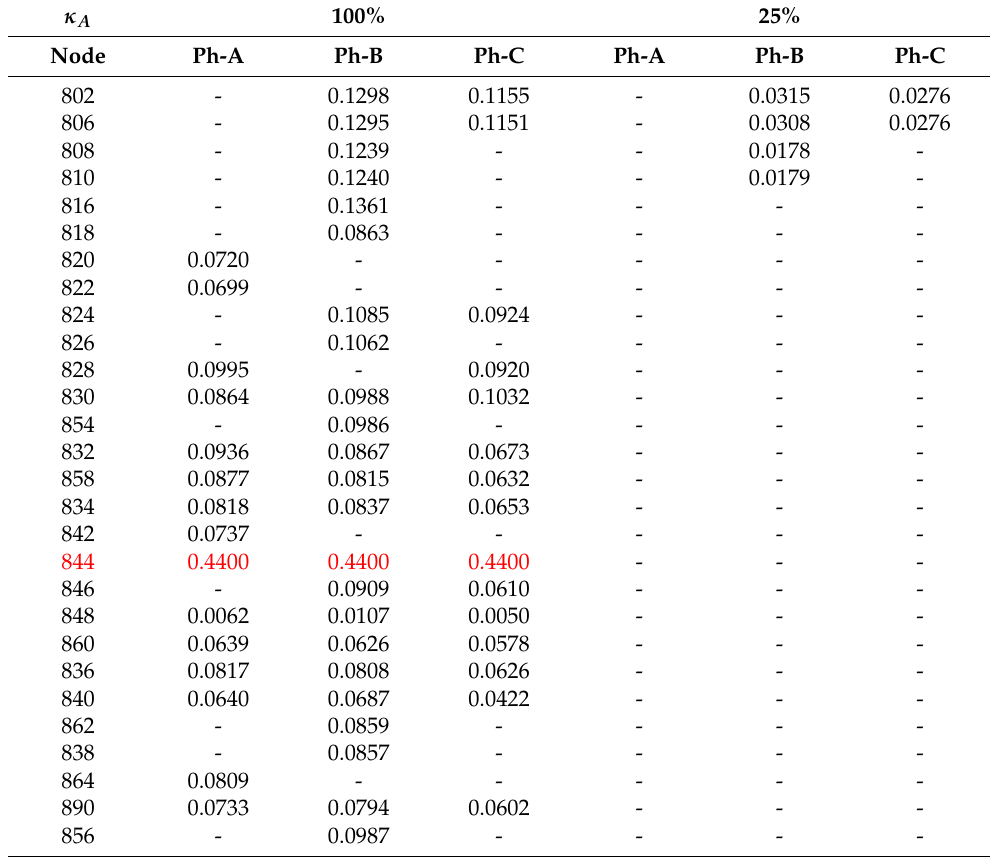
Figure 9. Operation modes with 25% and 100% of κ A using the proposed method. Table 1. κ R values in nodes with 100% and 25% of κ A for IEEE 34-Node Test